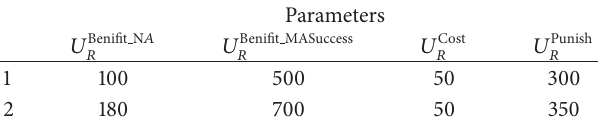
Table 2: Parameters settings of the example on Scene 2.